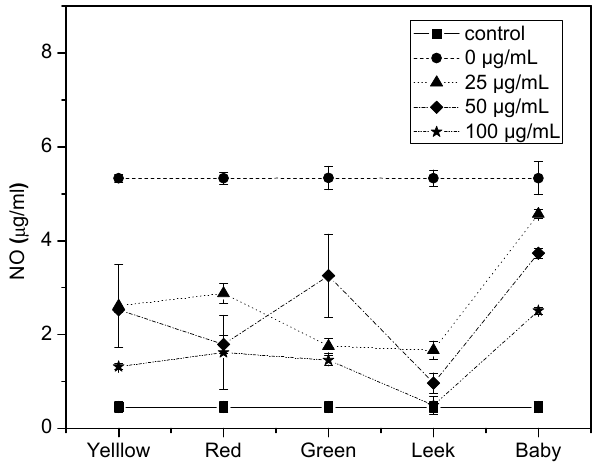
Figure 3. NO production of onion varieties.